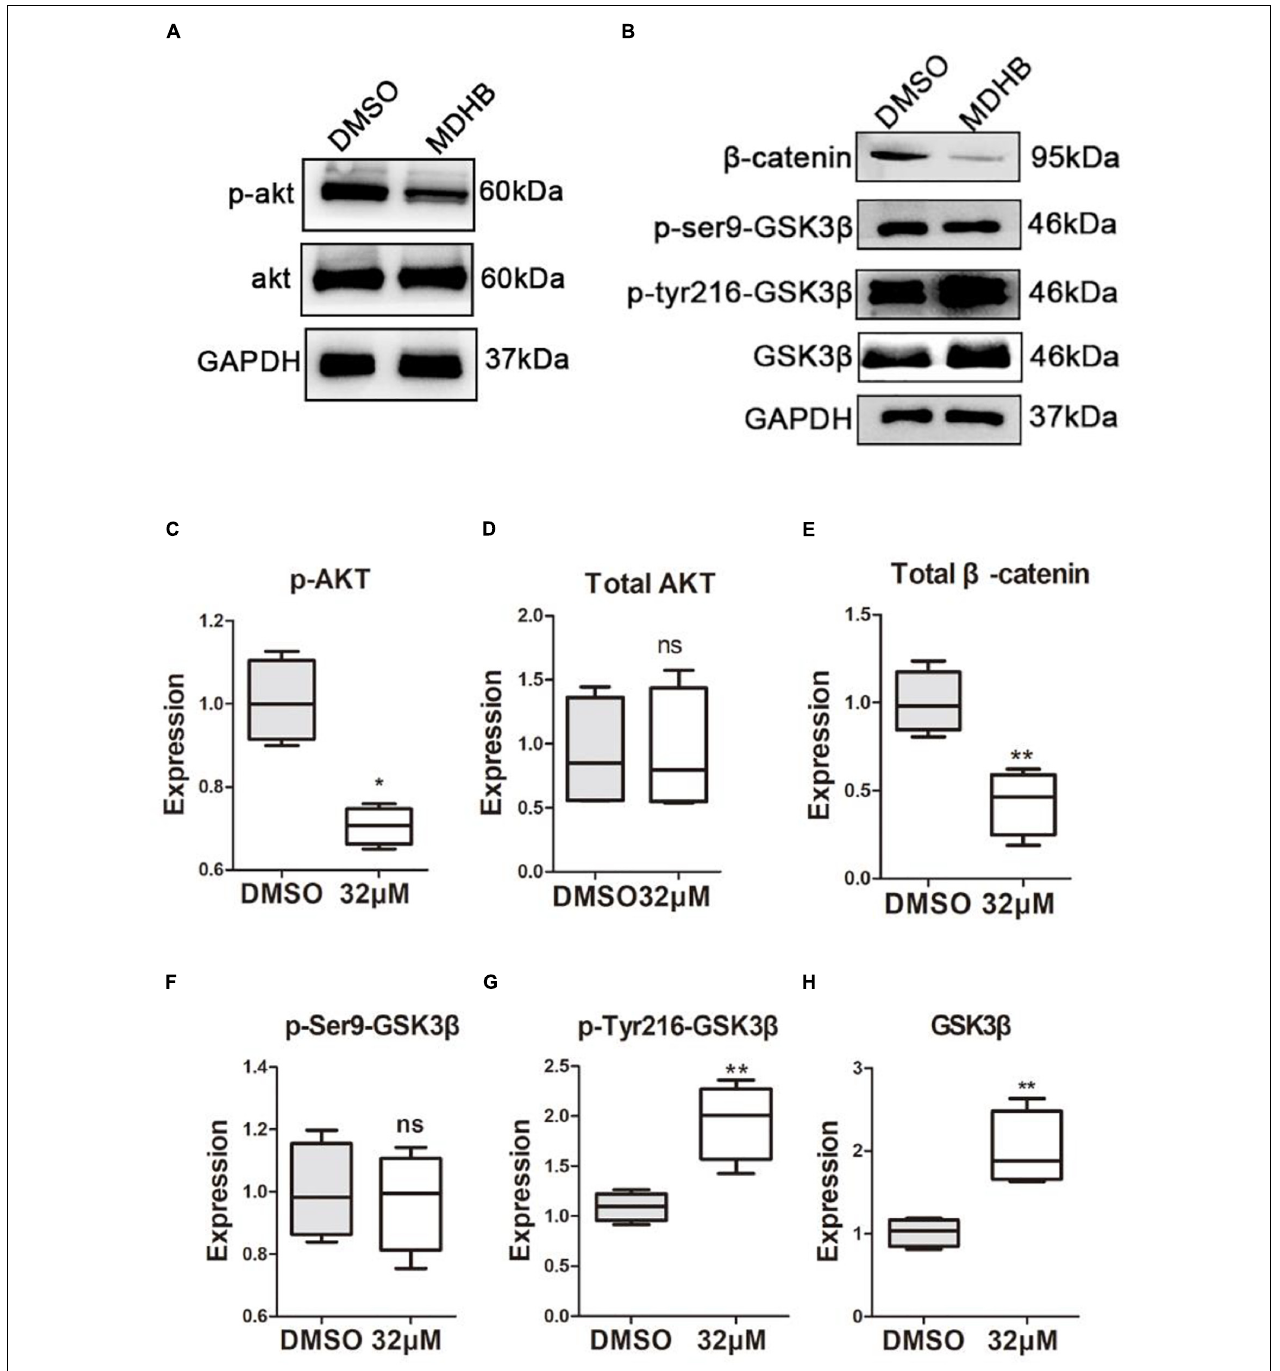
FIGURE 6 | The effect of MDHB on AKT, GSK3 β and β -catenin. MDHB inhibited phosphorylation of AKT in the differentiation of neural stem cells, activated phosphorylation of GSK3 β at tyrosine 216 (Y216), and downregulated transcription factor β -catenin. (A,B) Western blot analyses of proteins extracted from MDHB-treated neural stem cell in differentiation, (C–H) quantification of protein blots is shown, GAPDH serves as protein loading control. Each point represents the mean relative protein level of each group ( ∗ P < 0.05, compared with DMSO group, ∗∗ P < 0.01, compared with DMSO group, n =